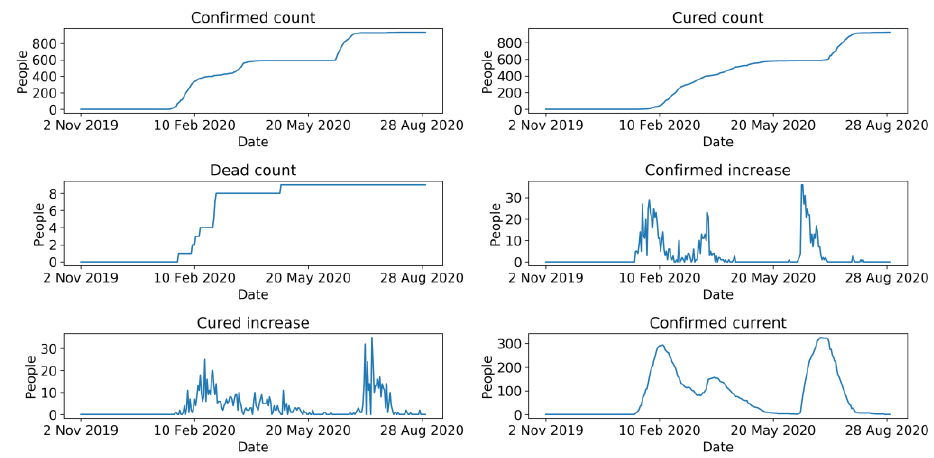
Figure 4. Curves of COVID-19 dataset.